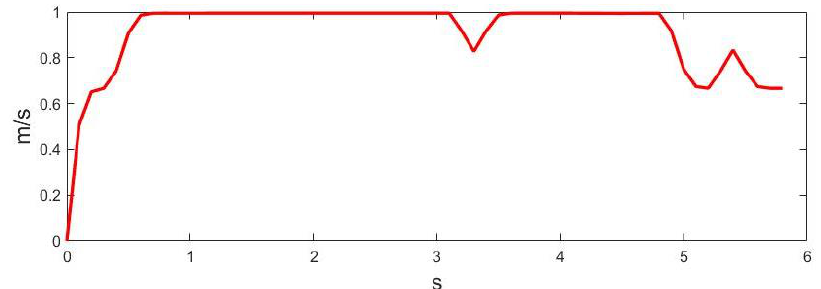
Figure 20. Linear velocity generated in the human-involved dynamic driving scenario.